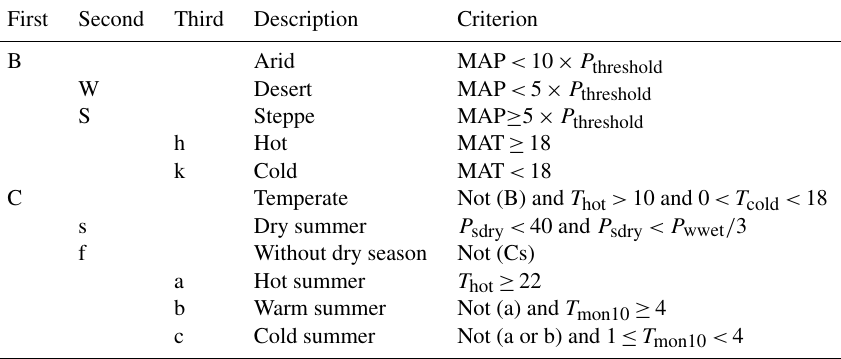
Table E2. The Köppen–Geiger Mediterranean climate classes, including the defining criteria, adapted from (Beck et al., 2018). MAT is the mean annual air temperature ( ◦ C), T cold is the air temperature of the coldest month ( ◦ C), T hot is the air temperature of the warmest month ( ◦ C), T mon10 is the number of months with air temperature > 10 ◦ C (unitless), MAP is the mean annual precipitation (mmyr − 1 ), P sdry is the precipitation in the driest month in summer (mm per month), P wwet is the precipitation in the wettest month in winter (mm per month), and P threshold is the 2 × MAT if > 70% of precipitation falls in winter, P threshold is the 2 × MAT + 28 if > 70% of precipitation falls in summer, or otherwise P threshold is the 2 × MAT + 14. Summer (winter) is the 6-month period that is warmer (colder) between April–September and October–March. First Second Third Description Criterion B Arid MAP < 10 × P threshold W Desert MAP < 5 × P threshold S Steppe MAP ≥ 5 × P threshold h Hot MAT ≥ 18 k Cold MAT < 18 C Temperate Not (B) and T hot > 10 and 0 <T cold < 18 s Dry summer P sdry < 40 and P sdry <P wwet / 3 f Without dry season Not (Cs) a Hot summer T hot ≥ 22 b Warm summer Not (a) and T mon10 ≥ 4 c Cold summer Not (a or b) and 1 ≤ T mon10 <